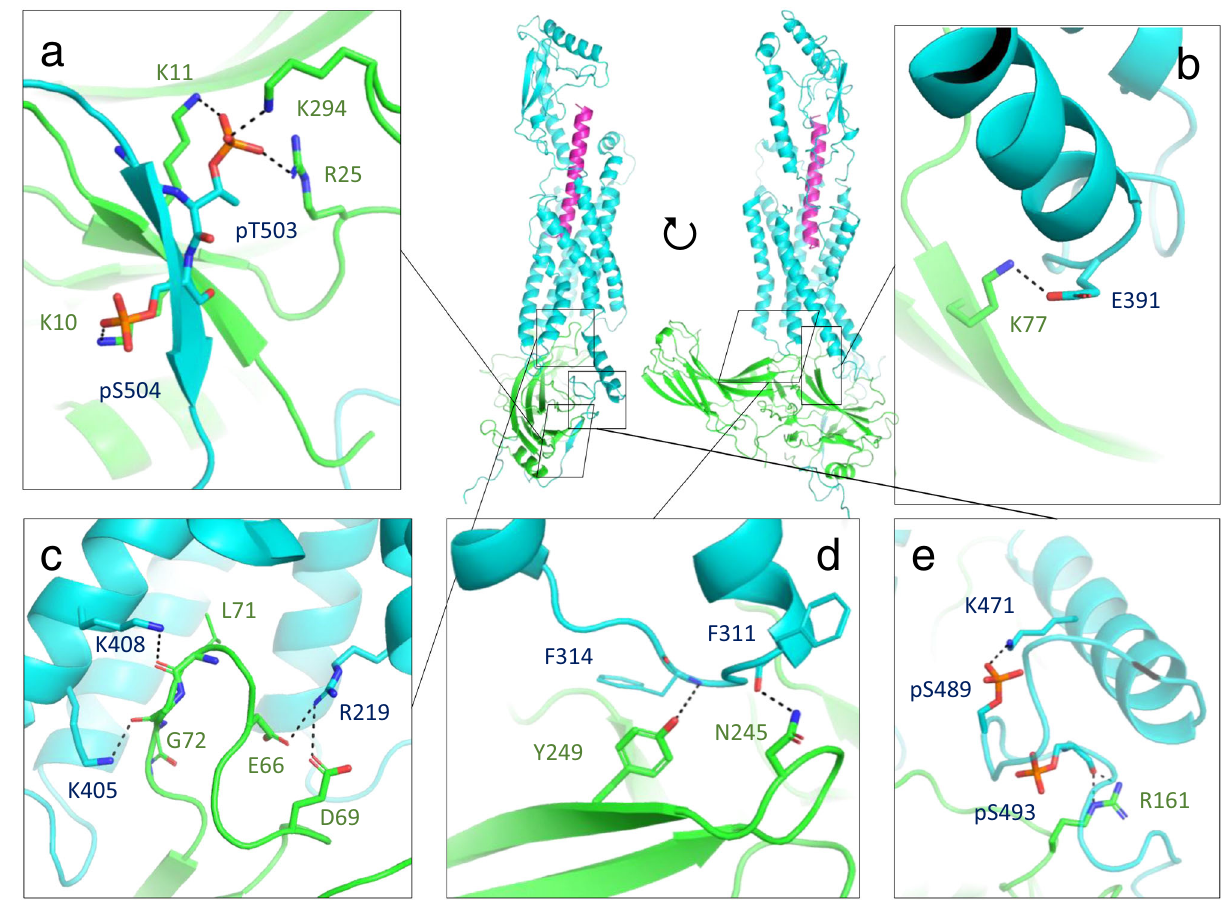
Fig.4|MolecularInteractionsintheoptimizedPTH1R-arr2modelbasedonthe M 2 R-arr2 template. Two views of the model containing long-acting PTH (PTHLA, magenta), arr2 (green), and PTH1R (cyan) are presented at the center. Interactions